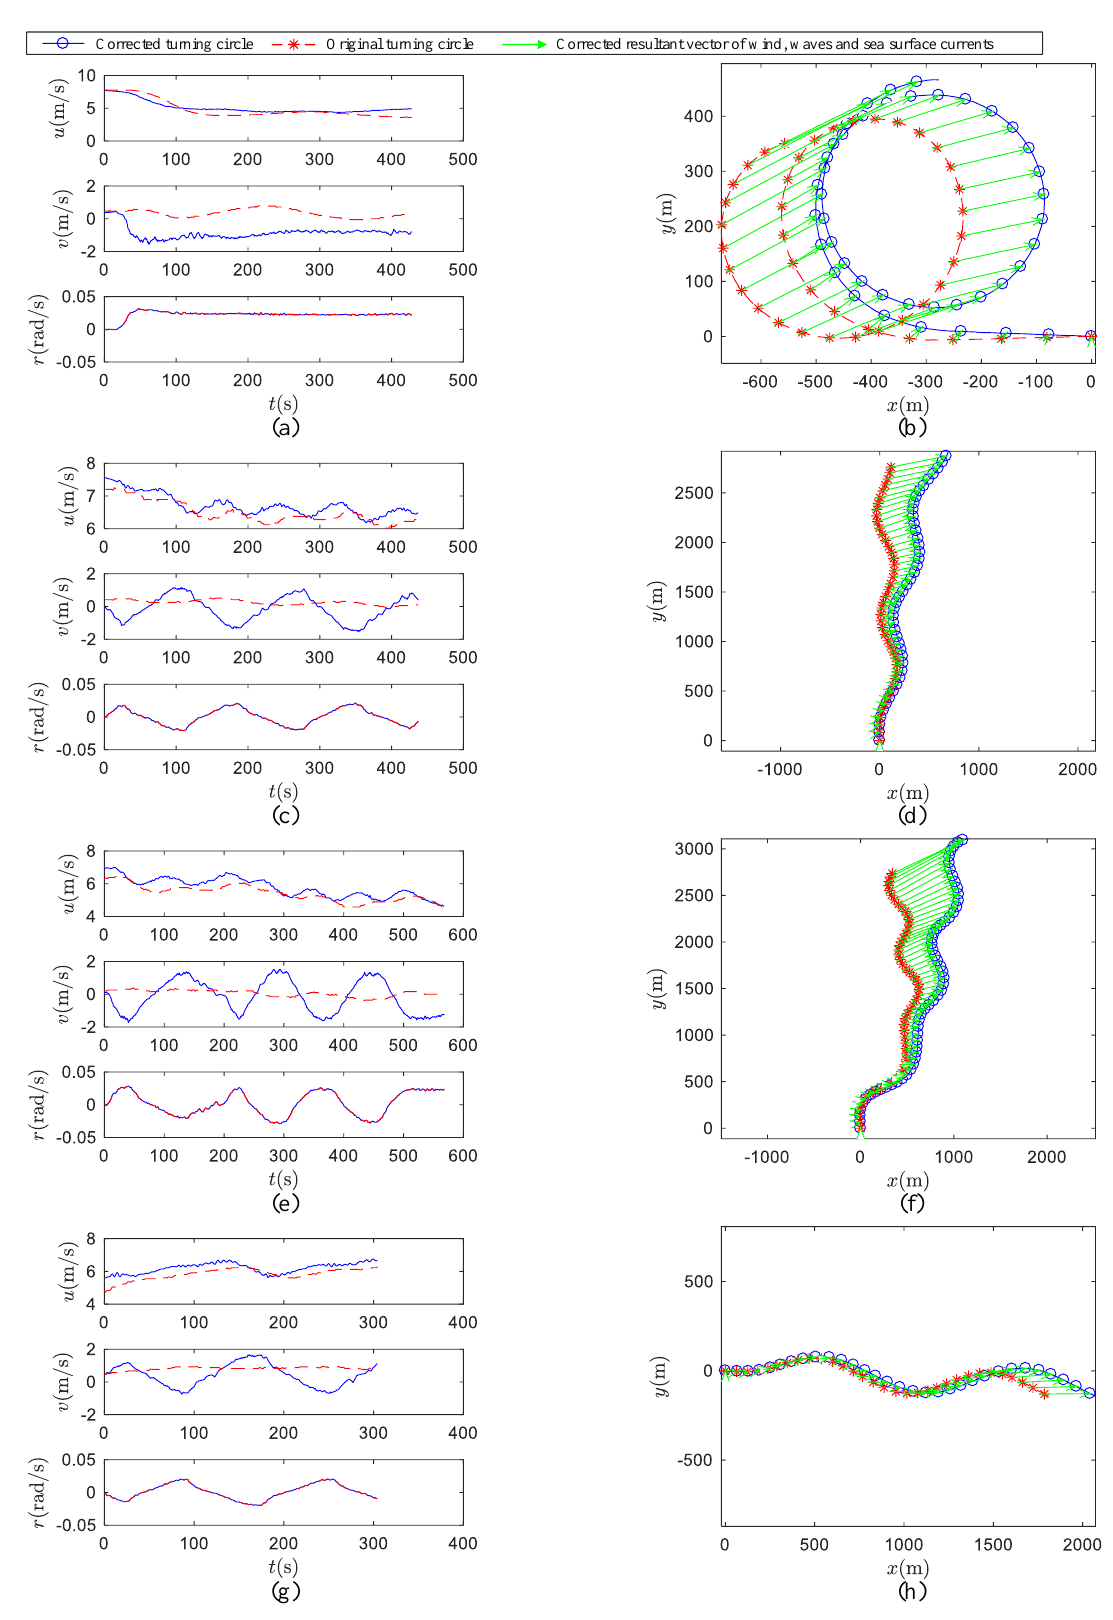
Figure A3. Correction result of track and velocities for test NO. 5–9. ( a ) Track of NO.5; ( b ) velocities of NO.5; ( c ) track of NO.6; ( d ) velocities of NO.6; ( e ) track of NO.7; ( f ) velocities of NO.7; ( g ) track of NO.8; ( h ) velocities of NO.8.